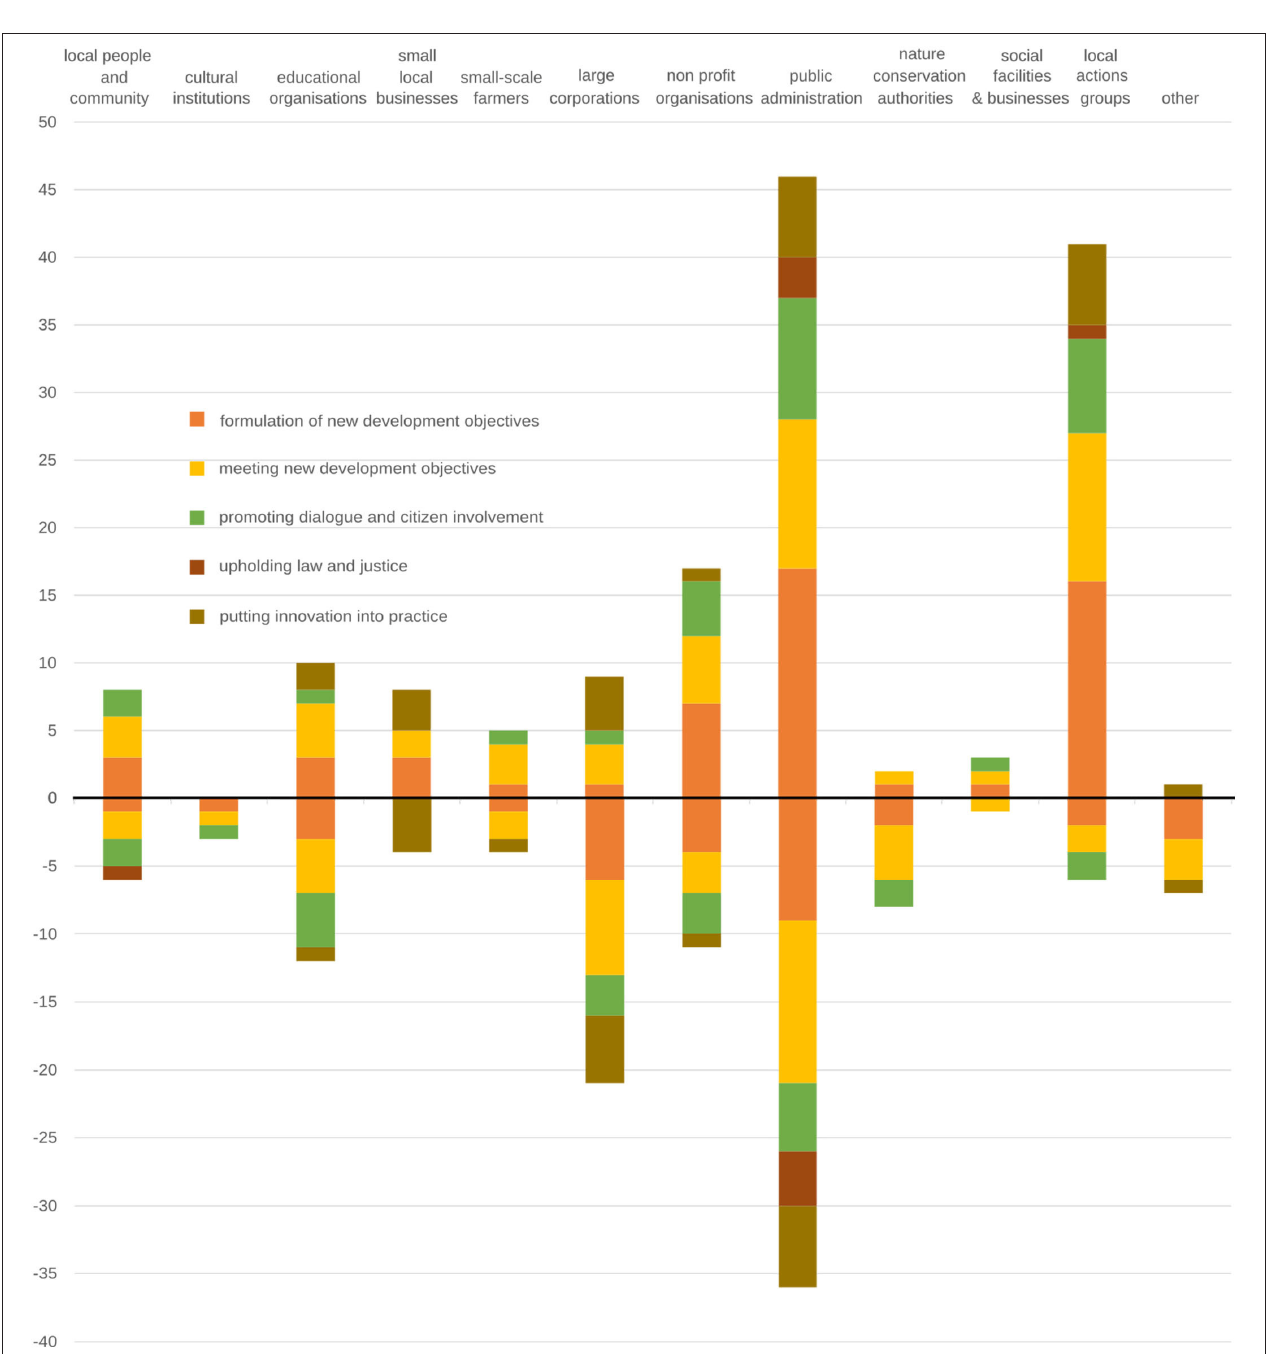
FIGURE 7 | To what extent do LAG representatives believe that selected actors are currently helping to initiate the sustainability changes in the following fields (the part of the graph with positive values), and for which changes toward sustainability that are not taking place to a sufficient extent would they need actors to help initiate them (the part of the graph with negative values). Here the answers to the following questions were compared: Which actors are CURRENTLY helping to START a discussion on sustainability in your LAG on the following topics? Which changes toward sustainability are NOT happening in your LAG to a sufficient extent, and list the actors you WOULD need to get them started. The questions were multiple choice (topics) with an open ended component (description of actors).